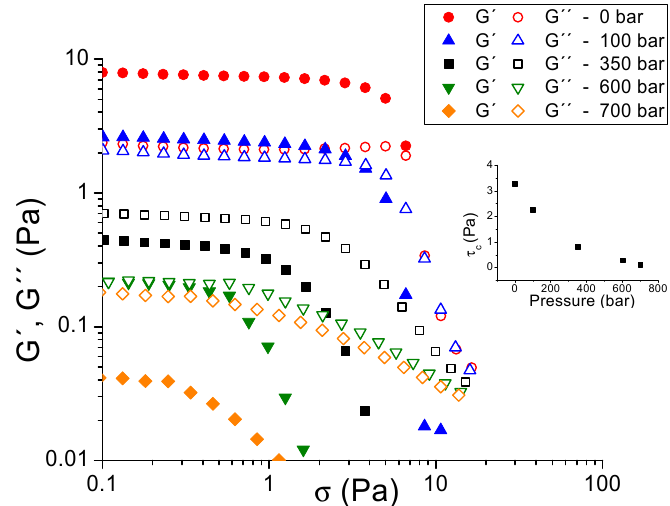
Figure 3. Stress sweeps for the continuous phase studied (Rhamsan-Welan ratio 0.5) as a function of the homogenization pressure applied in a microfluidizer at 0.1 Hz. Table 2. Critical shear stress obtained from stress sweeps for the continuous phases studied.